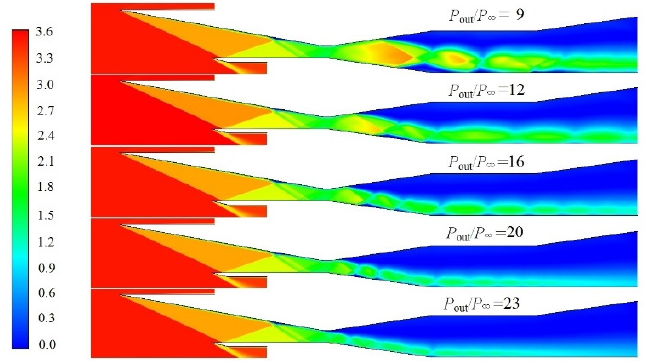
Figure 10. Comparison of the Mach number contours under different back pressure ratios P out /P ∞ . The lower-wall pressures with different back pressure ratios P out /P ∞ are shown in Figure 11. In the upstream of the throat, the pressure curves are consistent. Two pressure